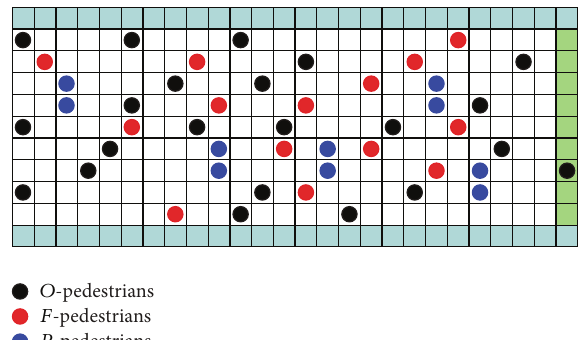
Figure 6: The random distribution of pedestrians at the initial time